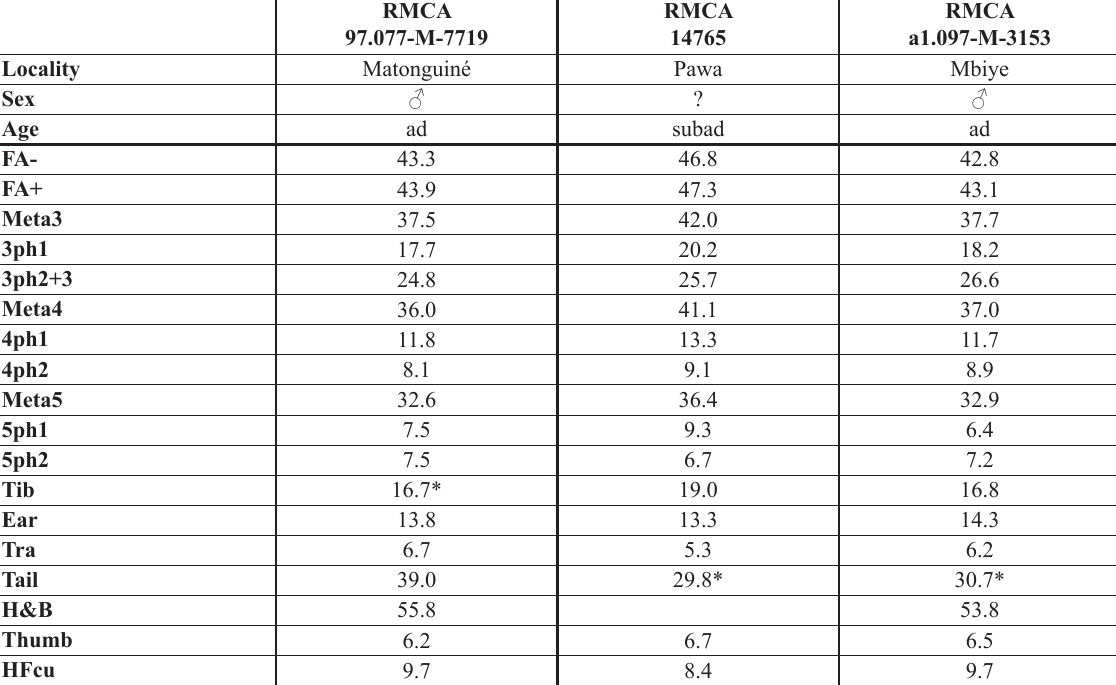
Table 3. External measurements (rounded to nearest 0.1 mm). For measurement descriptions see